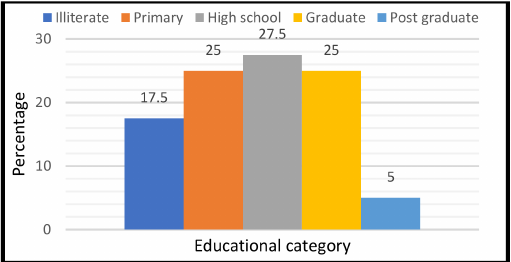
Figure 12. Educational background of the seed farmers.